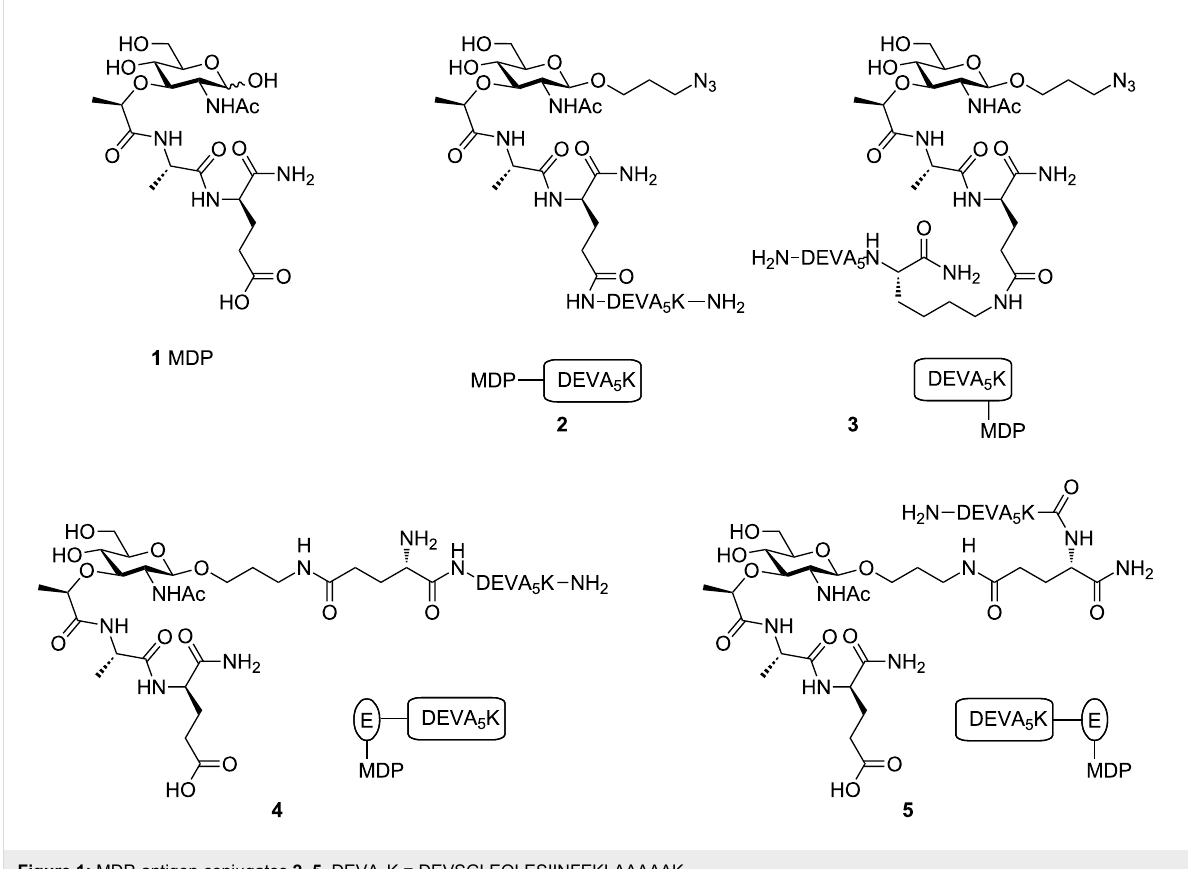
Figure 1: MDP-antigen conjugates 2 – 5 . DEVA 5 K =